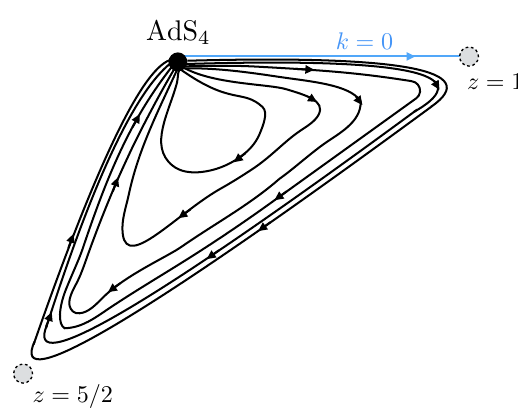
Figure 1 . Schematic picture of the family of boomerang RG (cid:13)ows, parametrised by (cid:0) =k which (cid:12)xes the strength of the relevant UV deformation. They all (cid:13)ow from the AdS 4 vacuum in the UV to the same AdS 4 vacuum in the IR. For su(cid:14)ciently large (cid:0) =k the solutions exhibit two intermediate scaling regimes in the bulk geometry. Both regions are of hyperscaling violation form given in (3.2): the (cid:12)rst is Lorentz invariant with z = 1, (cid:18) = (cid:0) 2 while the second has z = 5 = 2, (cid:18) = 1. Neither of the two intermediate scaling regimes are associated with exact solutions of D = 11